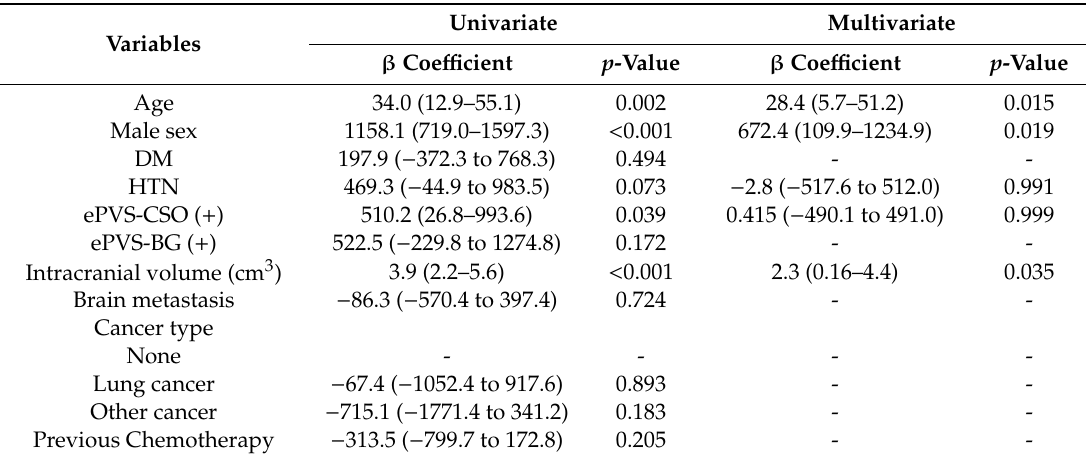
Table 2. Results of univariate and multivariate linear regression analyses to determine factors associated with peri-sinus lymphatic